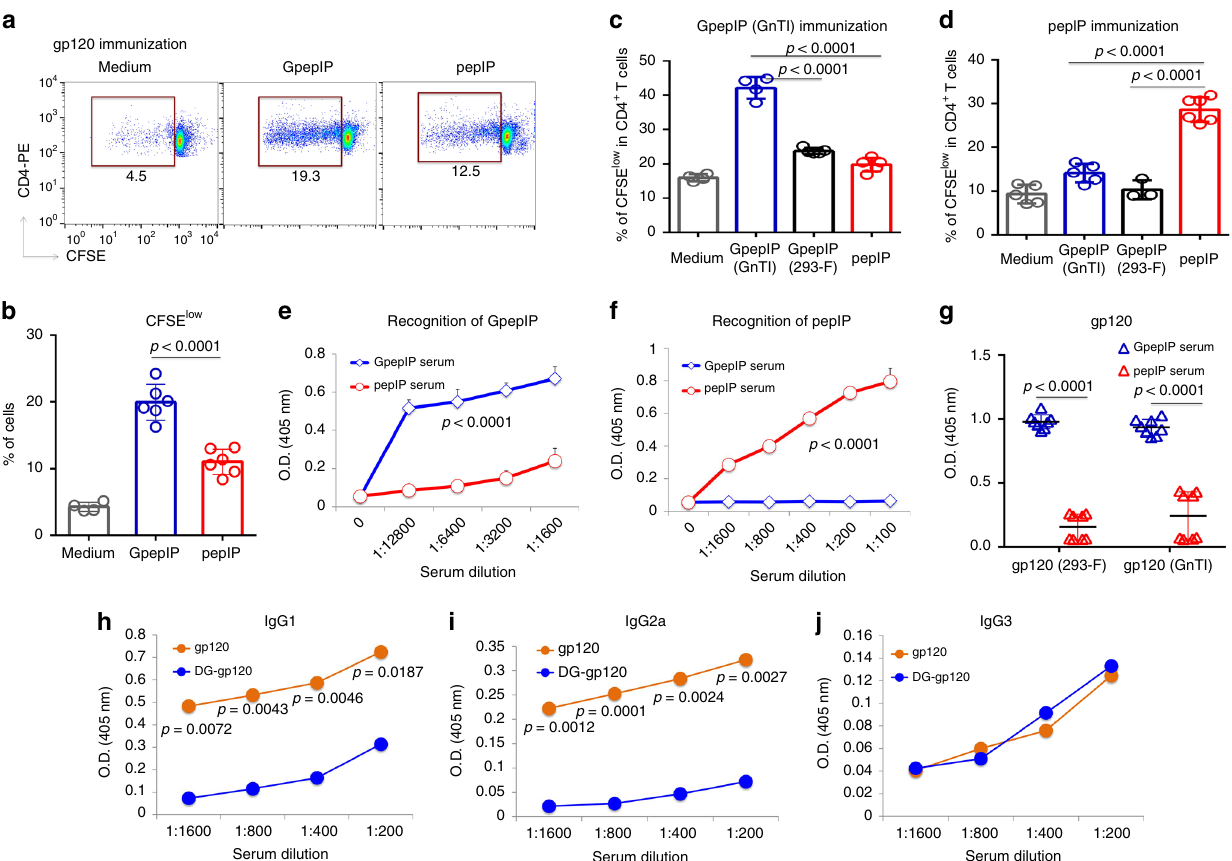
Fig. 3 The glycopeptide epitope GpepIP elicits a glycan-dependent cellular and humoral immune response. a , b CD4 + T cells obtained from mice immunized with gp120 were stimulated in vitro in the presence of mitomycin C-treated APCs pulsed with either GpepIP or pepIP, and T cell proliferation was examined by fl ow cytometry with use of CFSE fl uorescence dilution through cell division. c , d CD4 + T cells obtained from mice immunized with GpepIP expressed in GnT1 − / − cells c or with pepIP d were stimulated with GpepIP expressed in GnTI − / − or 293F cells or with pepIP in the presence of mitomycin C-treated APCs, and T cell proliferation was examined by CFSE fl ow cytometry. e , f Antisera from mice immunized with GpepIP or pepIP were titrated for IgG binding to immobilized GpepIP e or pepIP f by ELISA. g Antisera from GpepIP and pepIP immunization groups recognize gp120 expressed in 293-F and GnTI − / − cells differentially as measured by ELISA using a serum dilution 1:400. h – j Serum from mice immunized with GpepIP expressed in GnT1 − / − cells were collected 7 days after booster immunization. As a control, serum from naïve mice was used as background. Titers of IgG1 h , IgG2a i , and IgG3 j for recognition of glycosylated gp120 or deglycosylated gp120 were measured by ELISA. Data was presented after subtracting background. Representative results are shown from one of three independent experiments performed. (mean ± s.d.). b medium n = 4; GpepIP and pepIP n = 6 independent experiments. c medium and GpepIP (GnTI) n = 4; GpepIP (293-F) and pepIP n = 5 independent experiments. n = 4 for e and f ; n = 8 for g ; n = 2 independent experiments for h , i , and j . P -values were determined using Student ’ s two-sided t -tests. Source data are provided as a Source Data fi expression was observed in all sorted groups and cd69 and Il2 were and DG-gp120-speci fi c IgG3 subclass appeared comparable (Fig. 3j). upregulated in GpepIP-stimulated and pepIP-stimulated groups Consistent with results in Fig. 3e and f, GpepIP-immunized antisera compared to control (Supplementary Data 2 and 3). Hierarchical showed markedly greater binding to GpepIP than pepIP in all three clustering of genes from each group revealed three distinct gene IgG subclasses (Supplementary Fig. 6c – e). Taken together, these expression patterns with closer similarities between GpepIP and results demonstrate that the GpepIP epitope induces glycopeptide- pepIP cells than with control (Fig. 4b). Comparing transcriptomes of speci fi c CD4 + T cell and antibody responses. GpepIP and control cells, we found that 3001 genes were differen- tially expressed (greater than twofold, P < 0.05) with 2460 genes upregulated, 541 genes downregulated and 12,711 genes unchanged GpepIP induces favored Th2 and Th17 differentiation . To (Supplementary Data 2 and Fig. 4c left). Gene ontology (GO) further characterize the CD4 + T cell responses induced by the non- analysis showed a large fraction of differentially expressed genes conventional MHC ligand — GpepIP — and to obtain a gene expres- (DEGs) in GpepIP group enriched in the biological processes sion pro fi le of GpepIP-induced CD4 + T cells, we performed associated with cellular process, metabolic process, response to sti- genome-wide transcriptomic analysis (RNA-seq) comparing GpepIP mulus, signaling, and immune system process (Supplementary and pepIP-induced CD4 + T cell responses. Splenocytes from Fig. 7a). Kyoto encyclopedia of genes and genomes (KEGG) GnTI − / − -expressed GpepIP and pepIP immunized mice were sti- pathways analysis of DEGs identi fi ed the enriched pathways were mulated in vitro with GpepIP and pepIP, respectively, for 3 days. highly associated with immune functions, such as pathways Using T cell activation marker CD69, we sorted out CD4 + CD69 + T in cancer, in fl ammatory bowel disease (IBD), hematopoietic cell cell populations by fl ow cytometry whereas CD4 + CD69 − non- lineage, cytokine – cytokine receptor interaction and leishmaniasis. responding cells were used as control (Fig. 4a). High cd4 gene